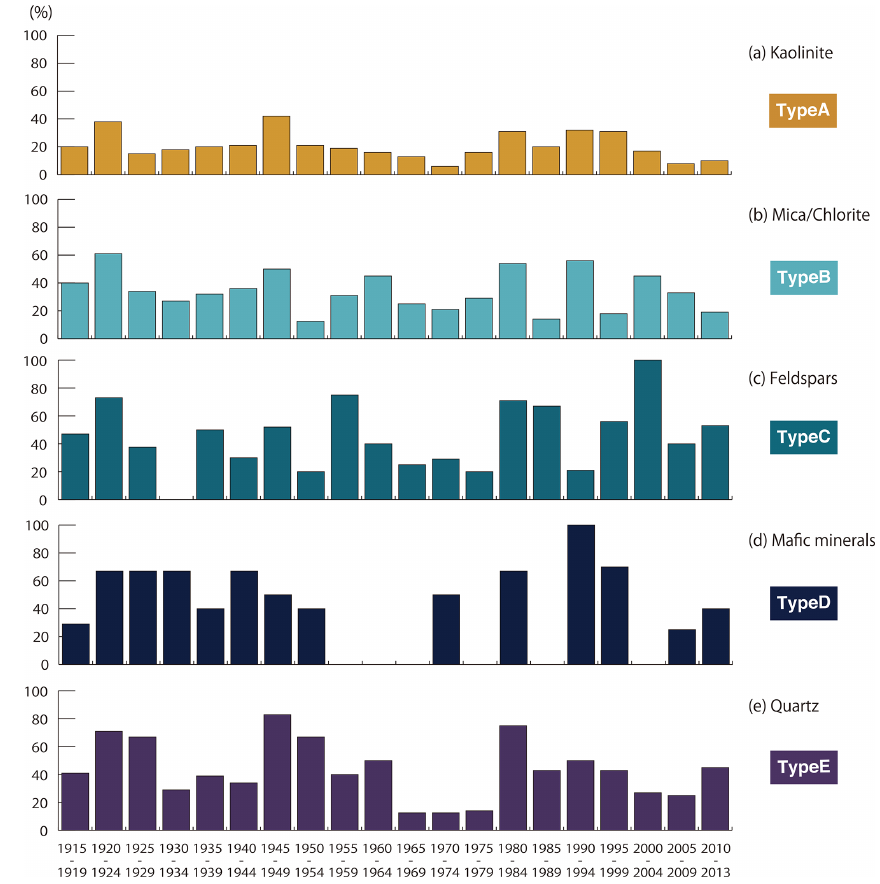
Figure 10. Historical changes in proportion of large particles (diameter > 2µm) in (a) kaolinite, (b) mica–chlorite, (c) feldspars, (d) mafic minerals, and (e)